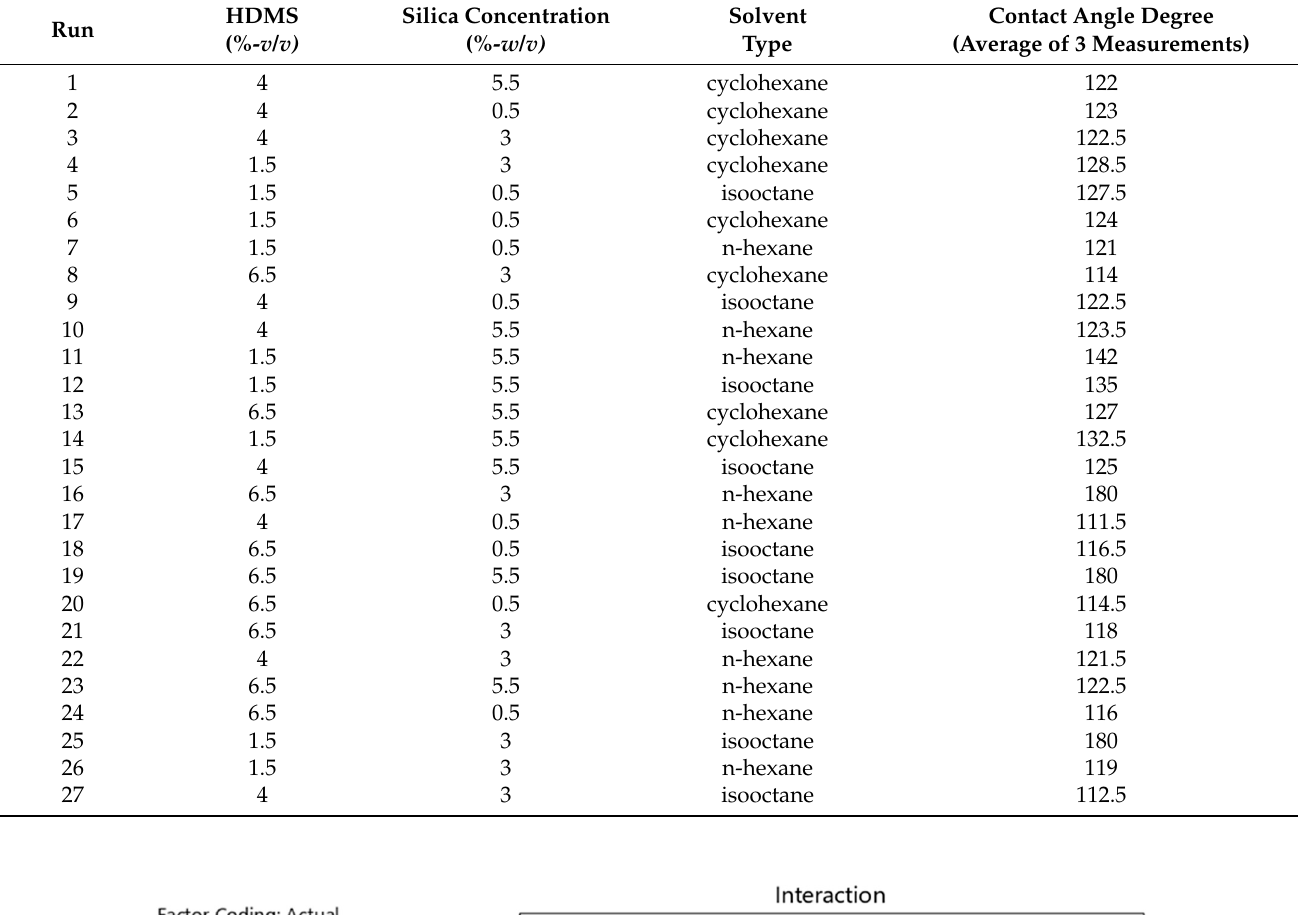
Table 3. Contact angle response with used hexamethyldisilazane (HMDS).